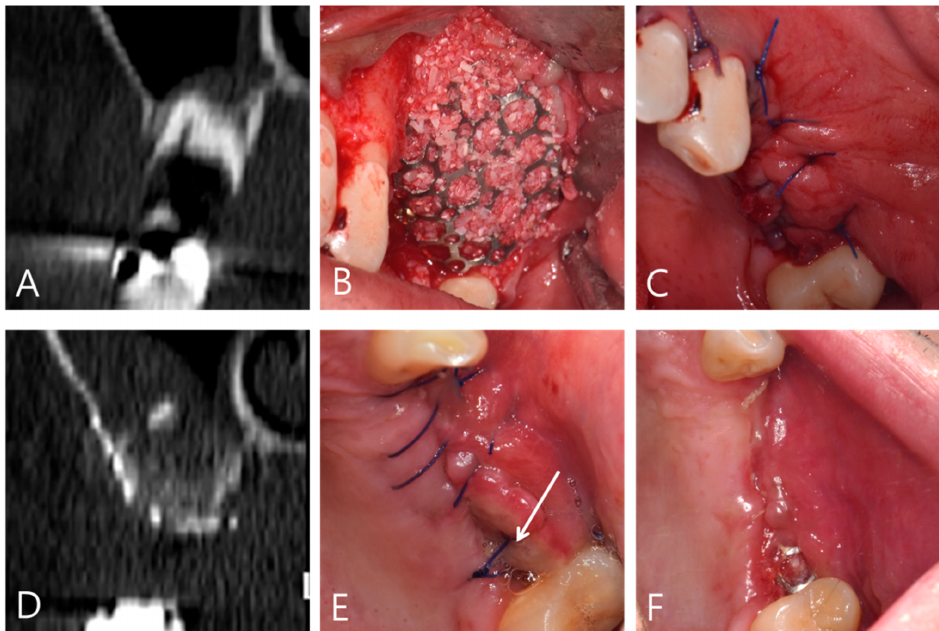
Figure 6. Wound dehiscence after autogenous tooth bone and autogenous bone graft with titanium mesh of case #3. ( A ) Pre-operative radiograph on the left maxillary first molar showed a lack of residual bone. ( B ) A bone graft was performed using DDM/rhBMP-2 and autogenous ramus bone grafts covering the titanium mesh. ( C ) Primary closure was achieved with tension-free flap management. ( D ) Postoperative radiograph showing bone augmentation on maxillary sinus and alveolar ridge. ( E ) At 1 week after surgery, the distal part of the flap showed dehiscence aspects (arrow). ( F ) Secondary healing was observed under the mesh at 3 weeks after the conservative treatment. At 6 months after the graft, the implants were placed with titanium mesh. (Figure 7) Appl. Sci. 2021 , 11 , x FOR PEER REVIEW Healed gingiva was observed with the exposed titanium mesh. (Figure 7A) On the dehiscence area, soft tissue was located under the titanium mesh dehiscence area (Figure 7B) and was connected to the buccal gingival (Figure 7C). On the other hand, acceptable bone healing was achieved, sufficient to secure the primary stability of the implant (ø 6.0 mm, Dentium, Korea) (Figure 7D,E).